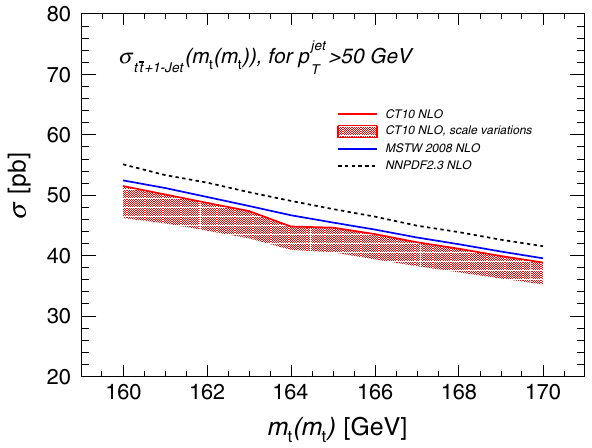
Fig. 1 The t ¯ t + 1 -jet + X cross section at NLO QCD for proton- proton collisions at 7 TeV as a function of the running mass m t ( m t ) . The lines show the result of the calculation for μ = m t ( m t ) using different PDF sets: CT10 NLO (red solid line), MSTW2008nlo90cl (blue dashed-dotted line), NNPDF2.3 NLO PDF (black dashed line). The red shaded area shows the impact of the scale variation for the CT10 NLO PDF set, where μ = μ r = μ f has been varied in the